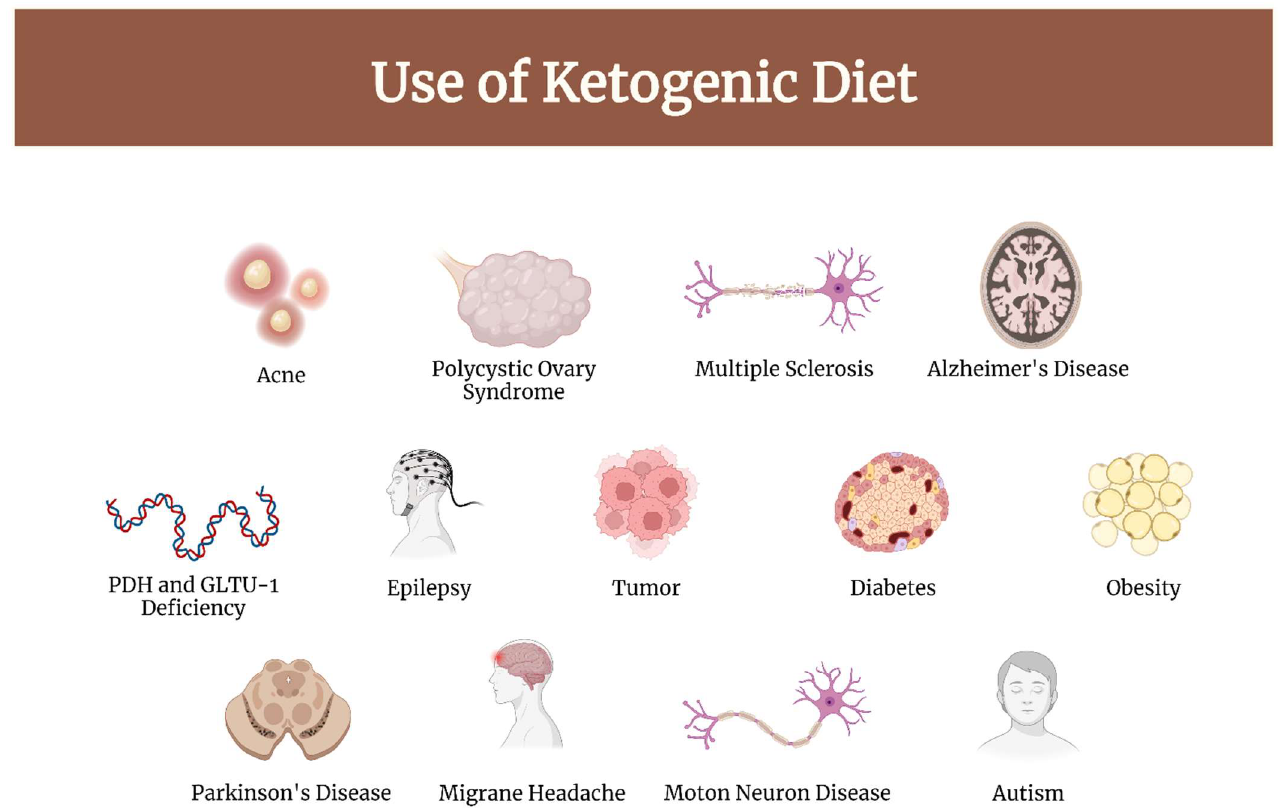
Figure 1. Diseases in which KD has demonstrated clinical efficacy.